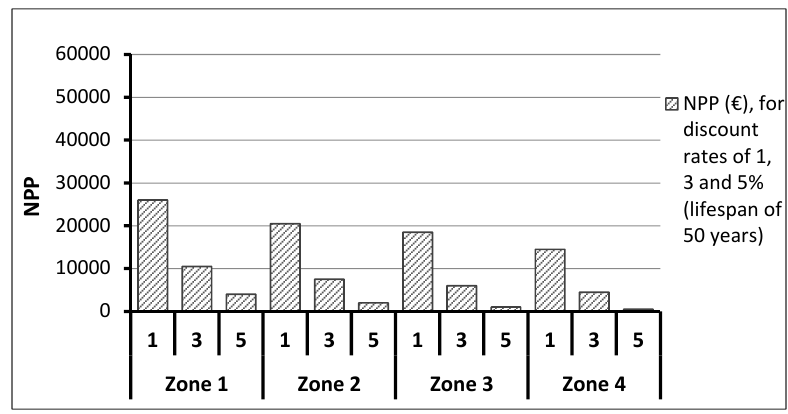
Figure 16. The cost-effectiveness of attic floor energy renovation, corresponding to the optimum